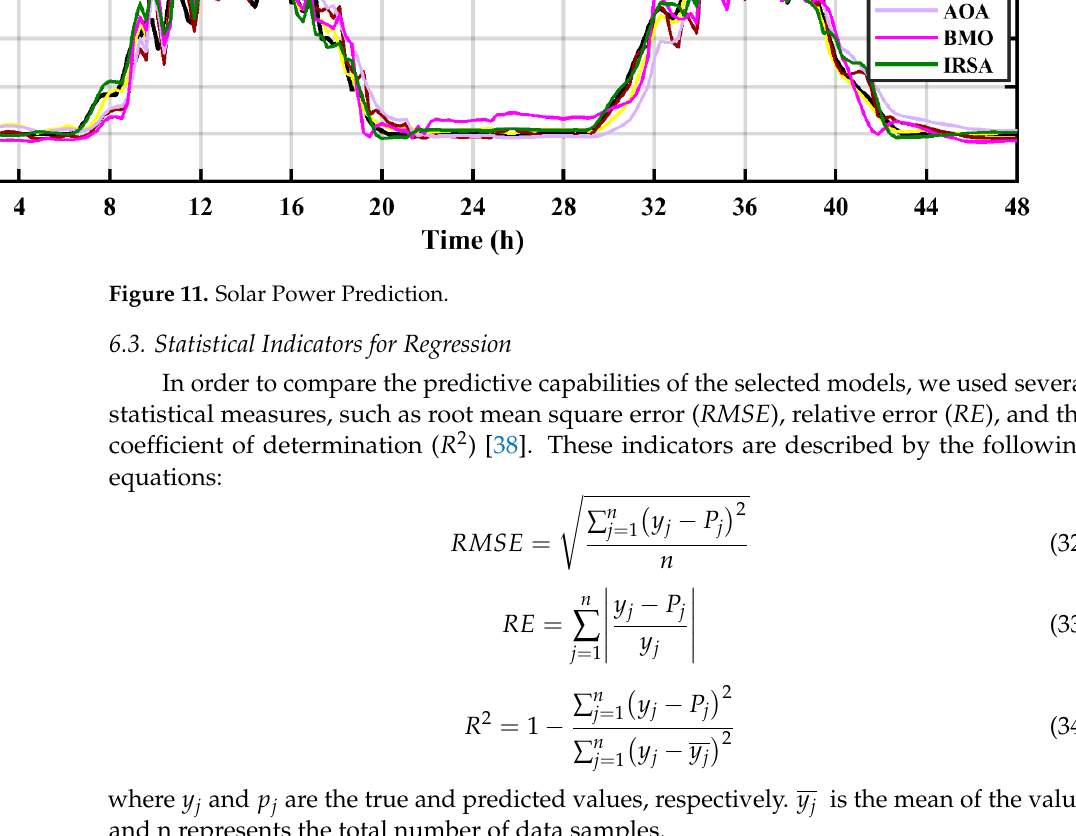
Figure 10. Wind Prediction (Summer)